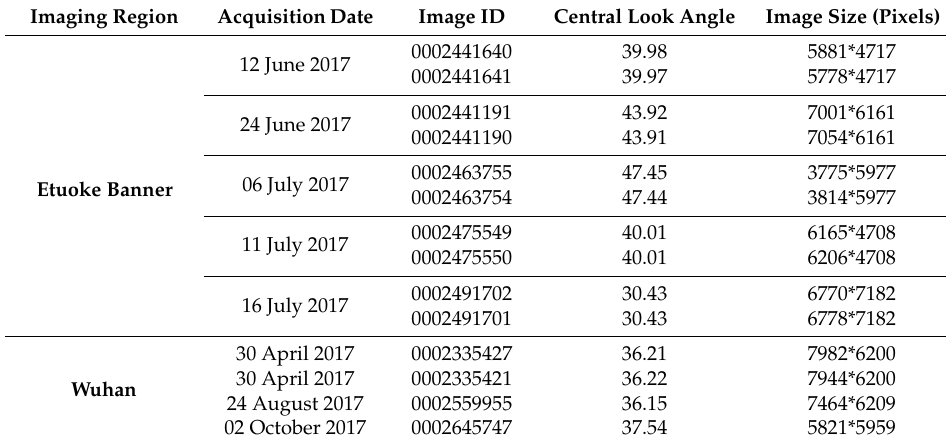
Table 2. Specific parameters of the experimental GF-3